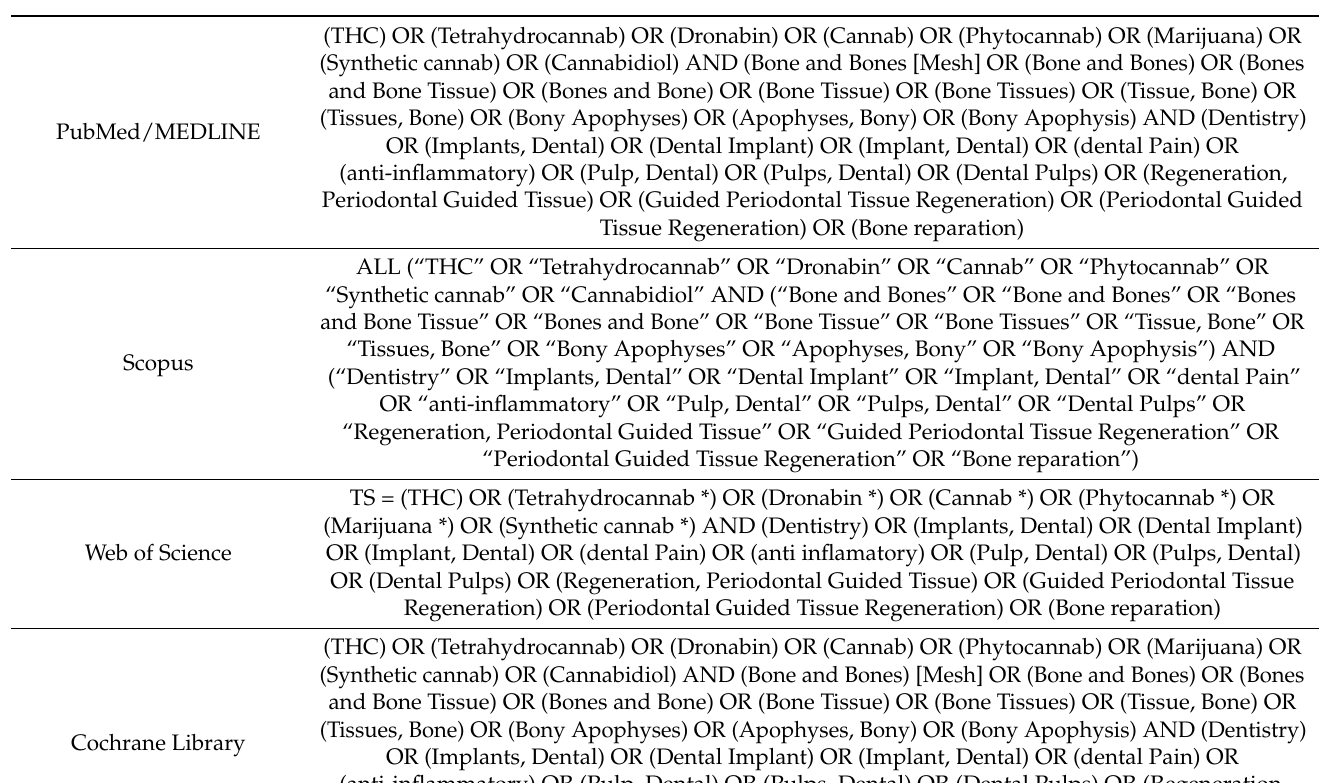
Table 1. Search strategy used in the different